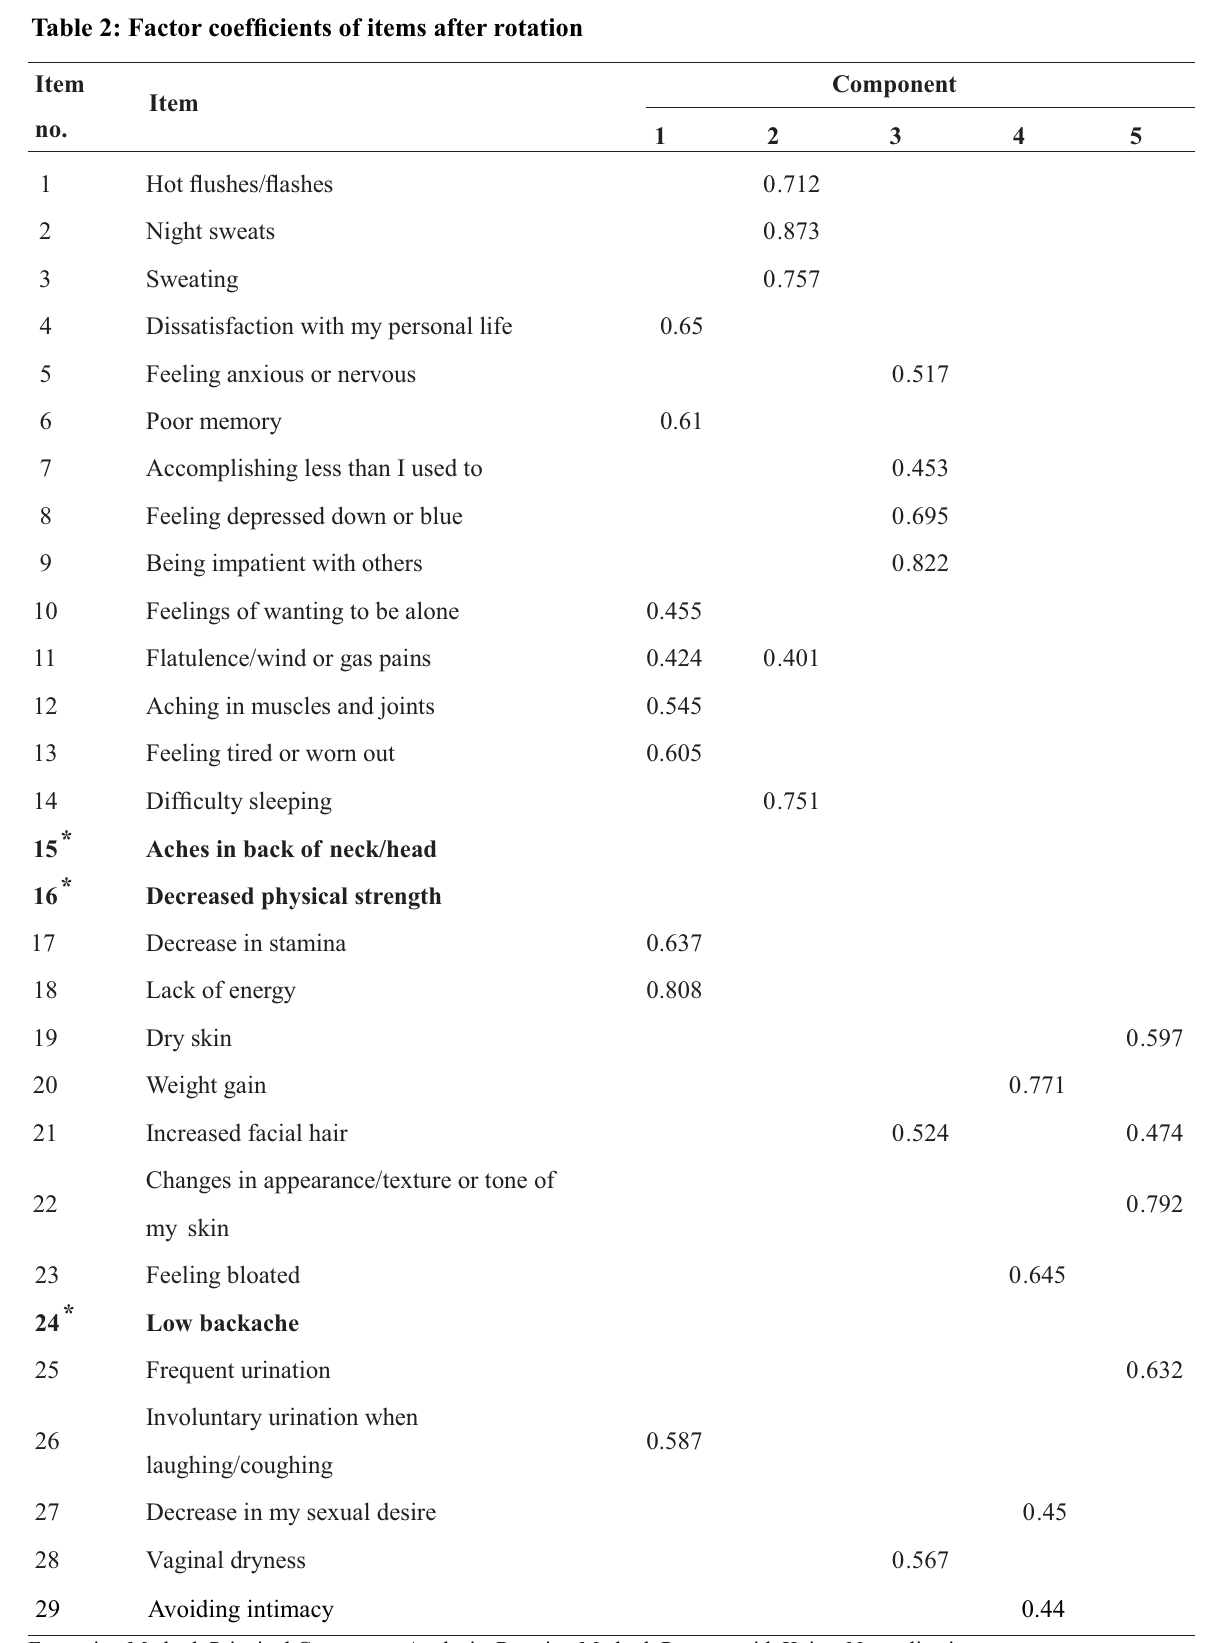
Table 2: Factor coefficients of items after